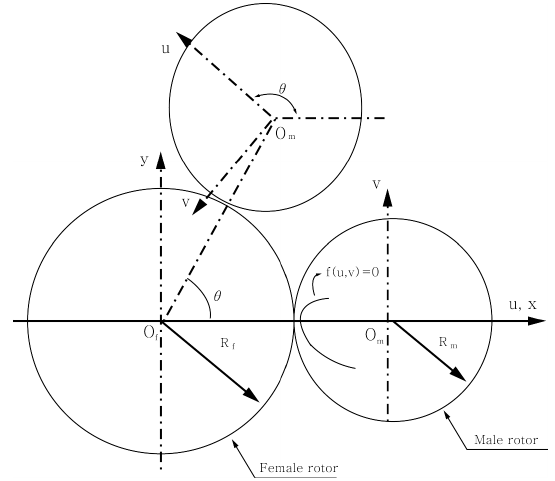
Figure 1. The coordinate systems of the modeled screw rotors.